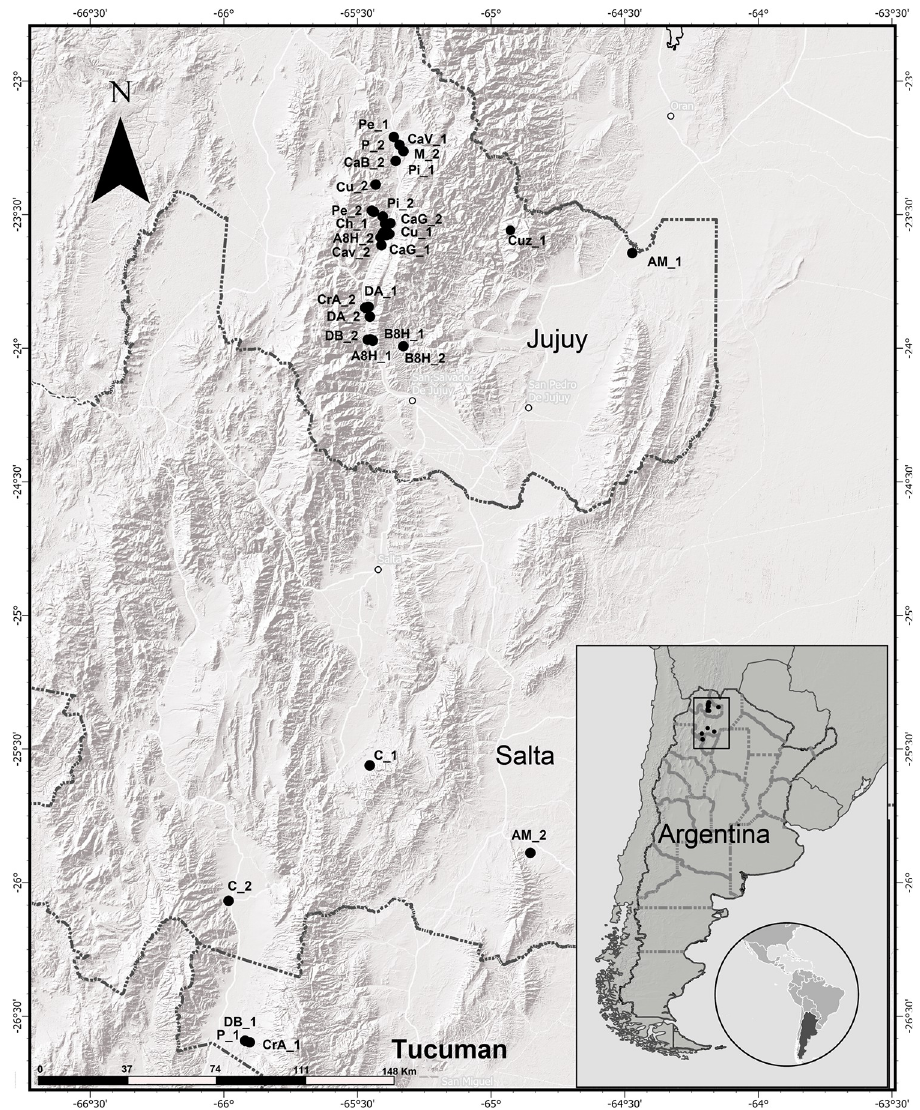
Fig 1. Collection sites of the landraces included in this study. Further details are provided in S1 Table. Map images were obtained from Aster Global Digital Elevation Model V003 (https://catalog.data.gov/dataset/aster-global-digital-